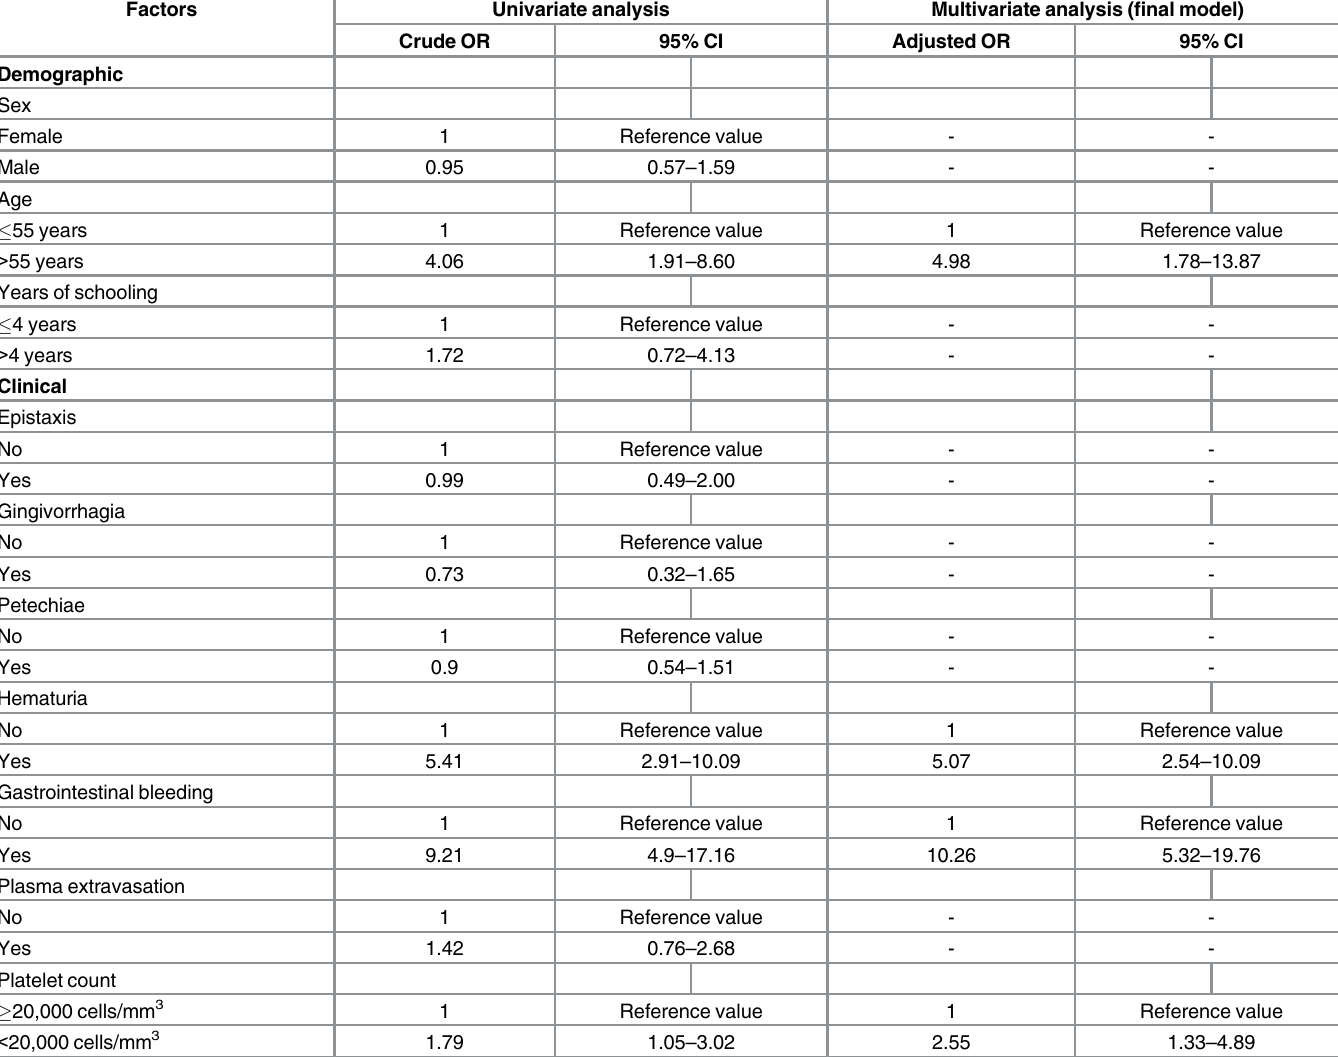
Table 2. Relationship between deaths due to severe dengue and demographic and clinical factors in the state of Amazonas, in the period from 2001 to